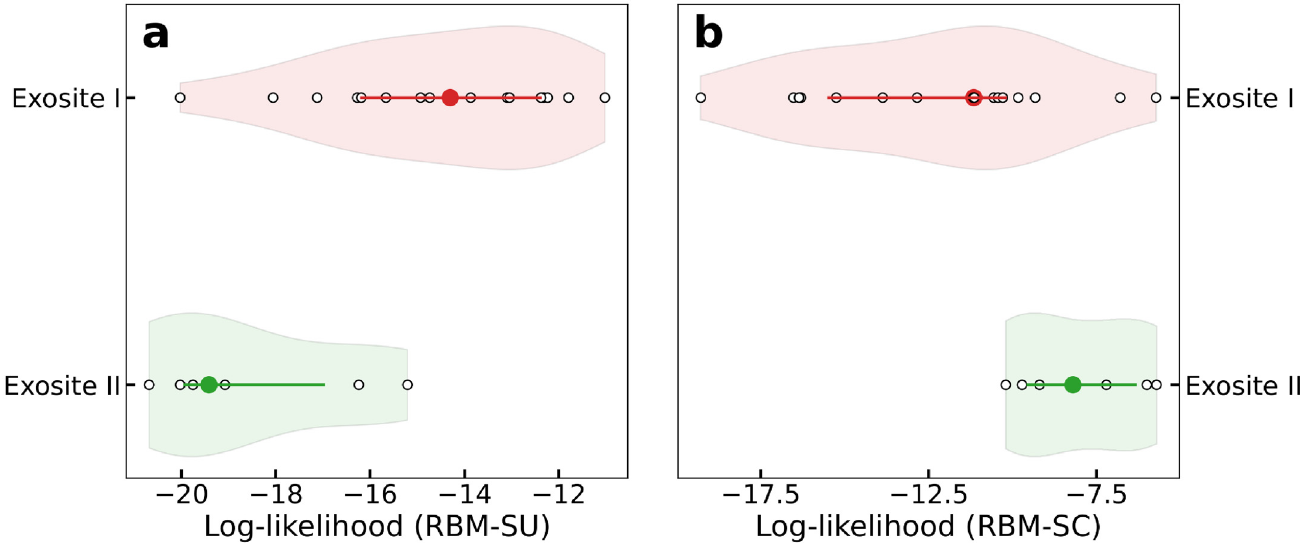
Fig 8. Aptamers binding to exosite I have larger log-likelihoods with RBM-SU, lower log-likelihood with RBM-SC. Violin plots showing the log-likelihoods of exosite I (light orange violin) and exosite II (light green violin) binders. Circles in darker colors denote the average log-likelihood over the class, lines denotes 25- and 75-percentiles, and white points corresponds to the log-likelihoods of the generated sequences. In panel A RBM-SU is used, while in panel B RBM-SC is used.